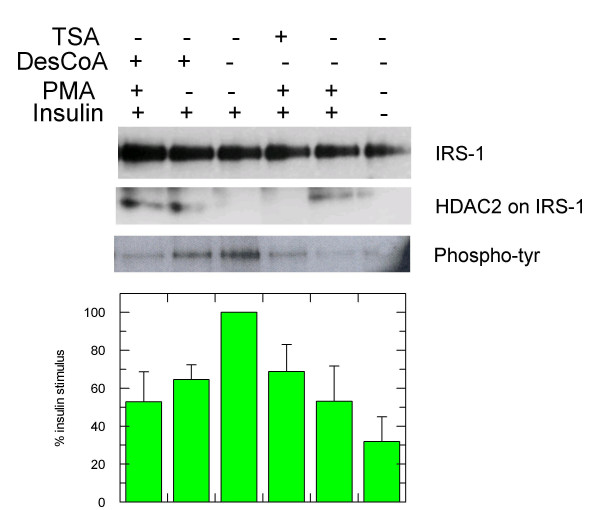
Inhibition of HAT activity inhibits insulin signalling. MCF-7 cells were treated with PMA, TSA and DesCoA (10 nM) in the indicated combinations for four hours prior to stimulation with insulin for 10 minutes. IRS-1 was immunoprecipitated and western blotted for the presence of IRS-1 itself, HDAC2 and phosphotyrosine. The graph shows average data for phosphotyrosine from three independent experiments (± SEM) normalised to the response to insulin alone.